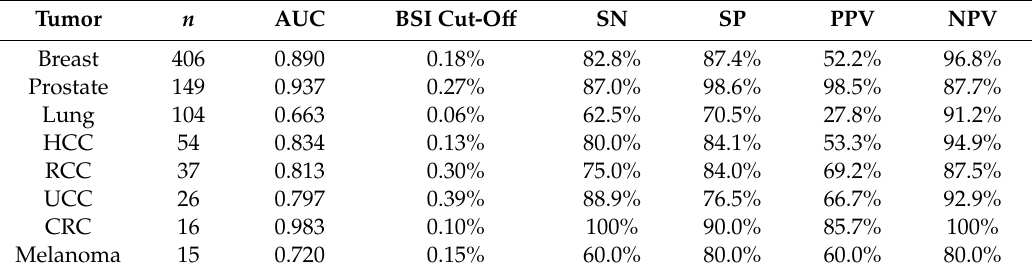
Table 3. BSI thresholds estimated from receiver operating characteristic (ROC) analysis for each examined tumor entity to distinguish between M0 and M1 situations.